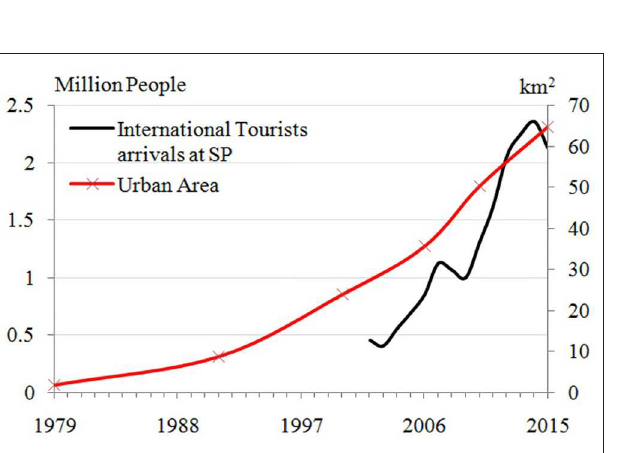
FIGURE 5 | (Left) Area change of forest, cropland and urban and built land from 1979 to 2015. (Right) Components of new urban area. The y-axis is the total area of urban and built land converted from the forest (F → U) , cropland (C → U) , and other (O → U) between two dates in km 2 .